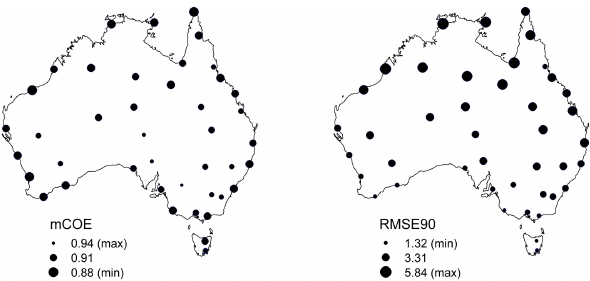
Fig. 7. Maps indicating the spatial variation of mCOE (left) and 90 th percentile RMSE (right) for GPT3 fitted using least squares estimation. Note that smaller circle sizes indicate a better fit (i.e. maximum mCOE and minimum RMSE).